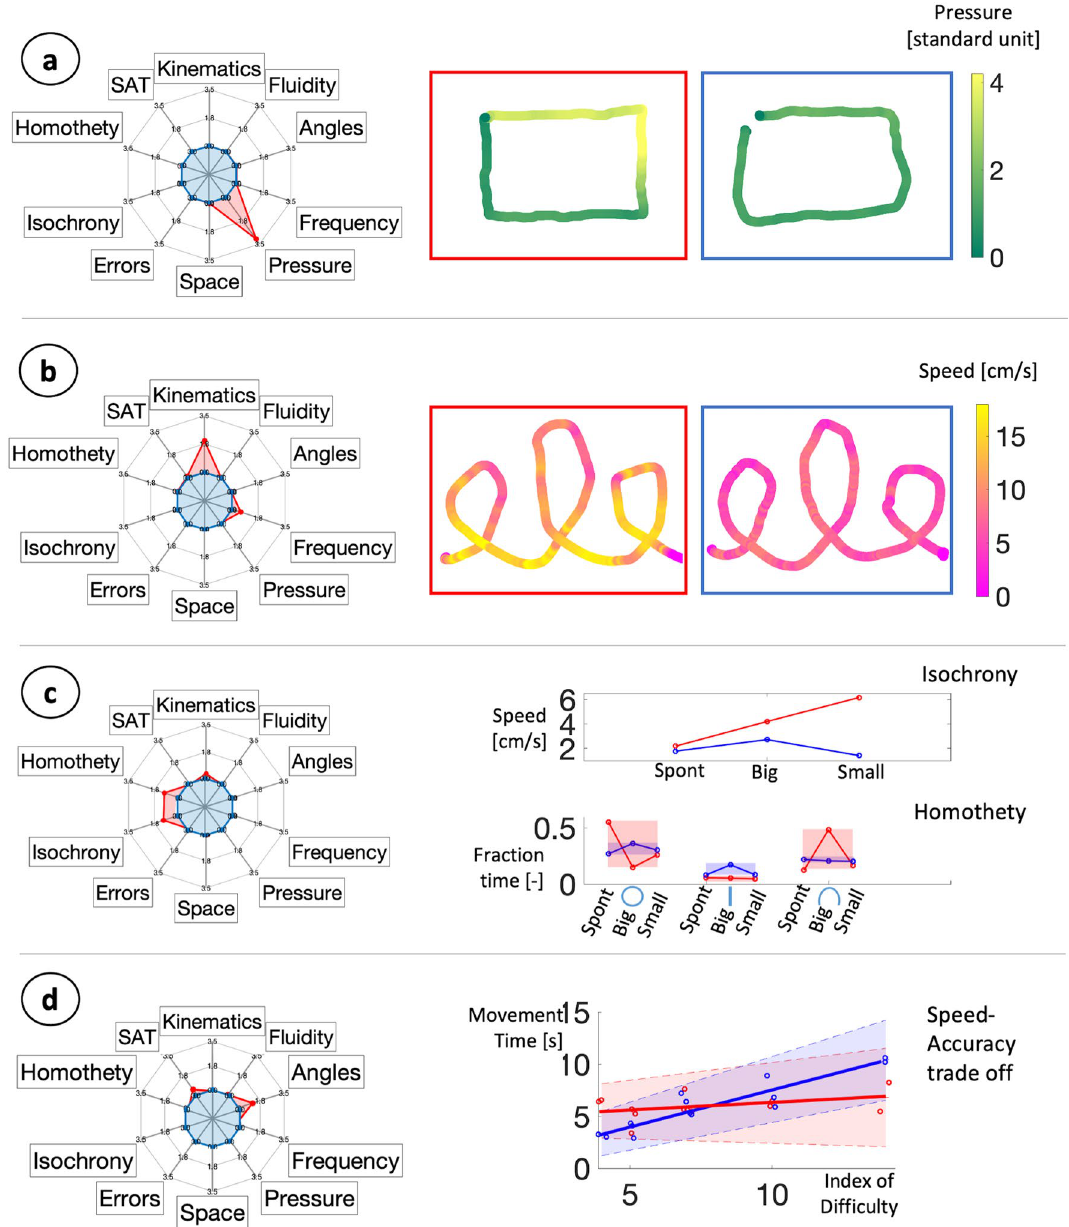
Figure 2. O-score correspondence with children executions. ( a–d ) report in red a sample subject with a high (i.e., bad) O-score in a specific feature category; in blue a sample subject with a low O-score. Axes of the radar plot show the O-score divided by feature category, computed only on the game shown in the right part of the Panels. ( a ) Pressure from TGS, colours correspond to pressure. ( b ) Kinematics from the TGW, colours correspond to execution speed. ( c ) Isochrony and Homothety from CGSe, speed and fraction time of spontaneous, big and small executions are shown. ( d ) Speed-Accuracy trade off from the